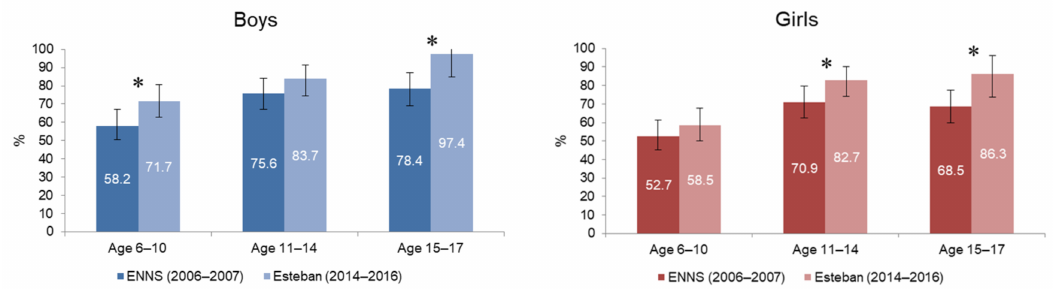
Figure 5. Prevalence of boys and girls aged 6–17 years spending two hours or more on screens 1 each day, between ENNS (2006–2007) and Esteban (2014–2016). 1 Screen time accumulates TV, computer and game console time. * significant change ( p <